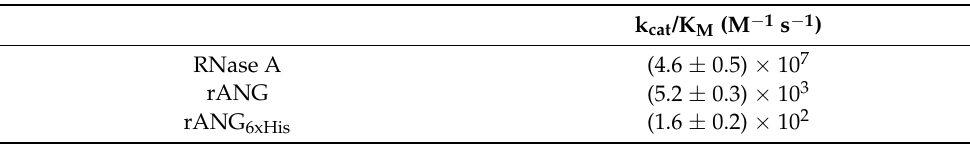
Figure 4. Superimposition of the CD spectra of ( A ) rANG, ( B ) rANG 6xHis and ( C ) H13A_rANG, registered at 20 °C before heating (plane line) and after cooling (dashed line). Spectra were recorded in 20 mM of MES/NaOH pH 6.0 and 100 mM NaCl, using a protein concentration of 0.1 mg mL − 1 . Table 1 . Ribonucleolytic activity of rANG and rANG 6xHis compared with that of RNase A. Each value is calculated as the average of three measurements.